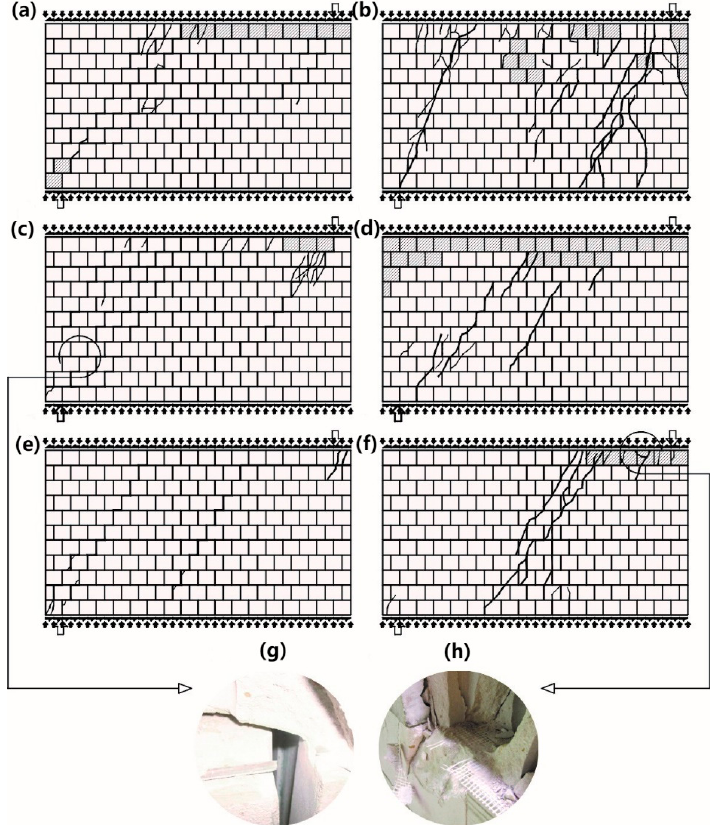
Figure 8. Cracking patterns of HOS series walls at the time of failure: (a) unreinforced shear wall at σ c = 0.1 N/mm 2 , (b) unreinforced shear wall at σ c = 1.5 N/mm 2 , (c) shear wall reinforced with steel trusses at σ c = 0.1 N/mm 2 , (d) shear wall reinforced with steel trusses at σ c = 1.5 N/mm 2 , (e) shear wall reinforced with plastic mesh at σ c = 0.1 N/mm 2 , (f) shear wall reinforced with plastic mesh at σ c = 1.5 N/mm 2 , (g) a broken truss, and (h) a broken plastic grid in the crush zone of a wall. At the time of failure, individual masonry units in the top layer of the wall were crushed.